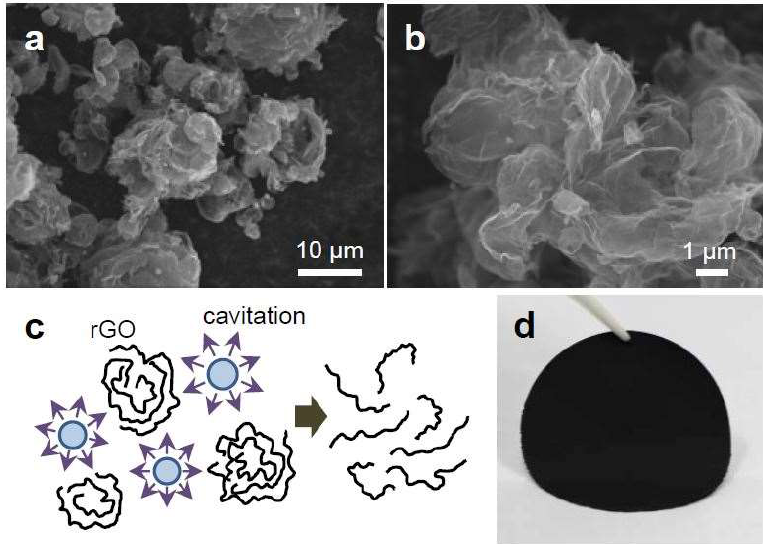
Figure 1. Fabrication of a graphene paper by using ultrasonication treatments on crumpled rGO powders. ( a , b ) SEM images of crumped and spherical rGO powders. ( c ) Schematic illustration of sonication treatment on the crumpled rGO powders. ( d ) Optical image of an rGO paper fabricated from the sonicated rGO powders.